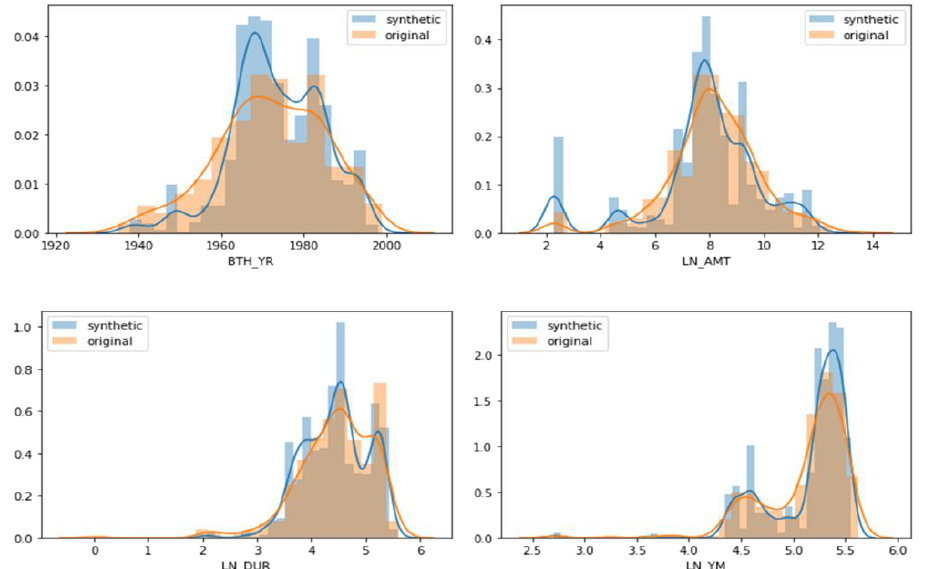
Figure 5. Univariate distribution comparison of Original (coral) and Synthetic(blue) datasets.